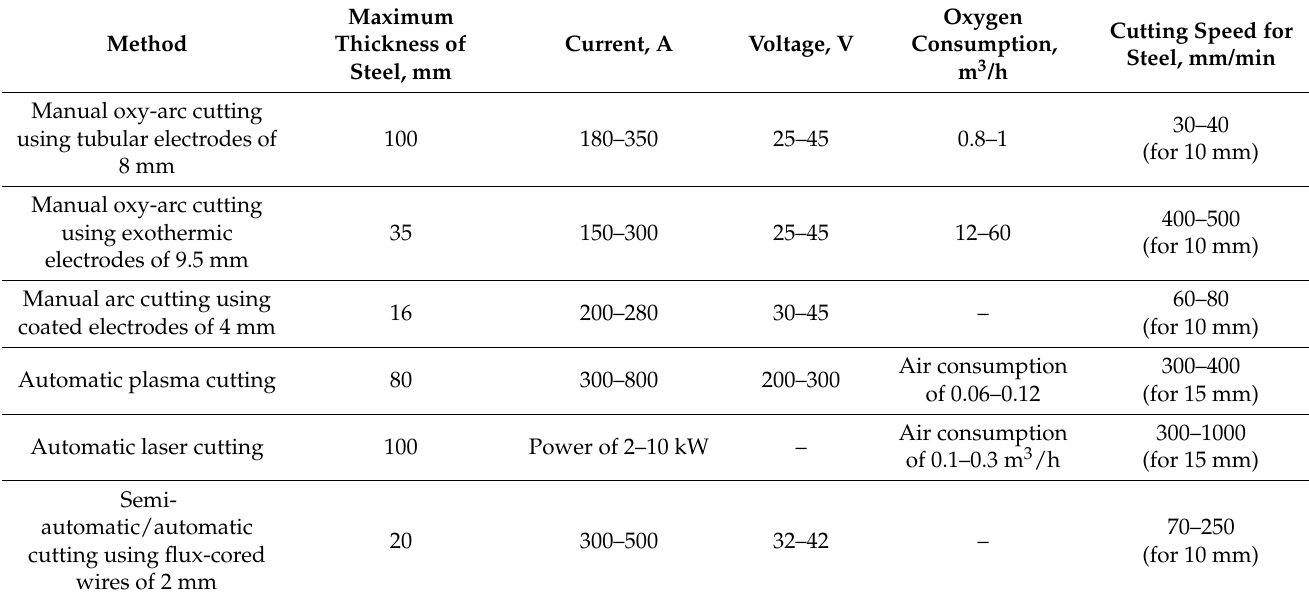
Table 1. Parameters of methods for underwater wet cutting of steels